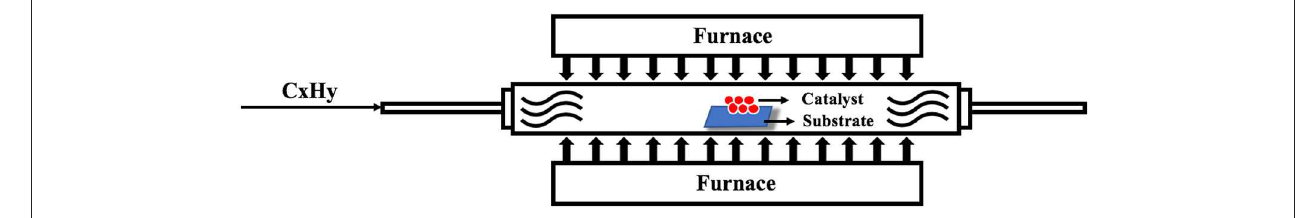
FIGURE 3 | Schematic diagram of CNT preparation of CVD